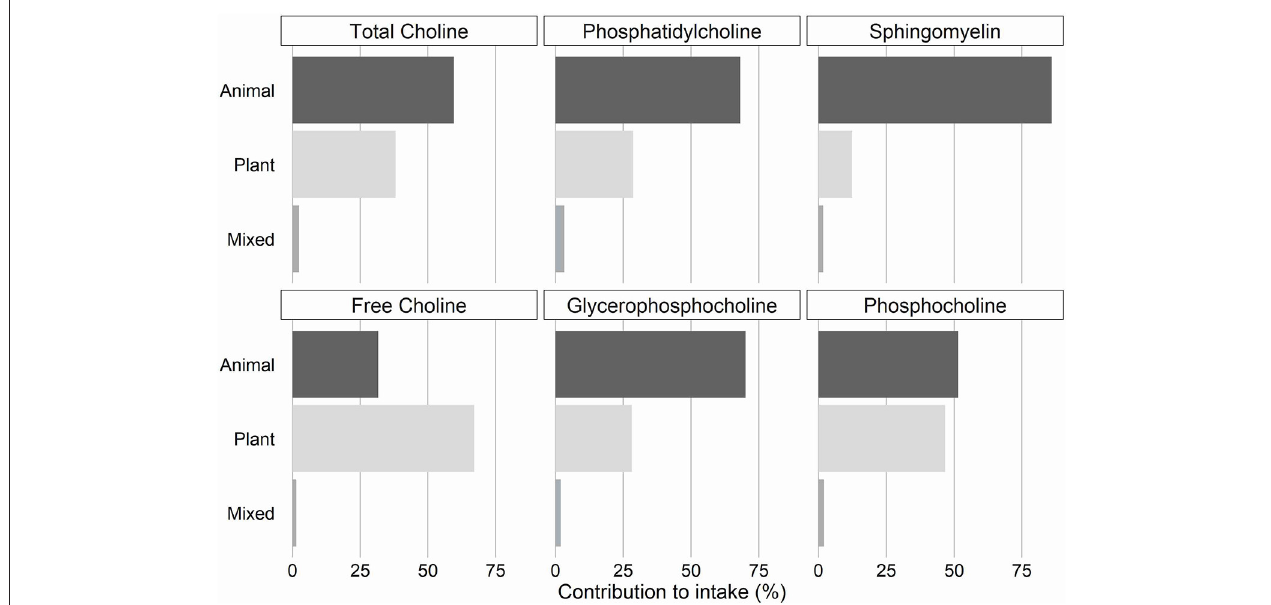
FIGURE 2 | Contribution of animal, plant or mixed food sources to intake of total choline and individual choline